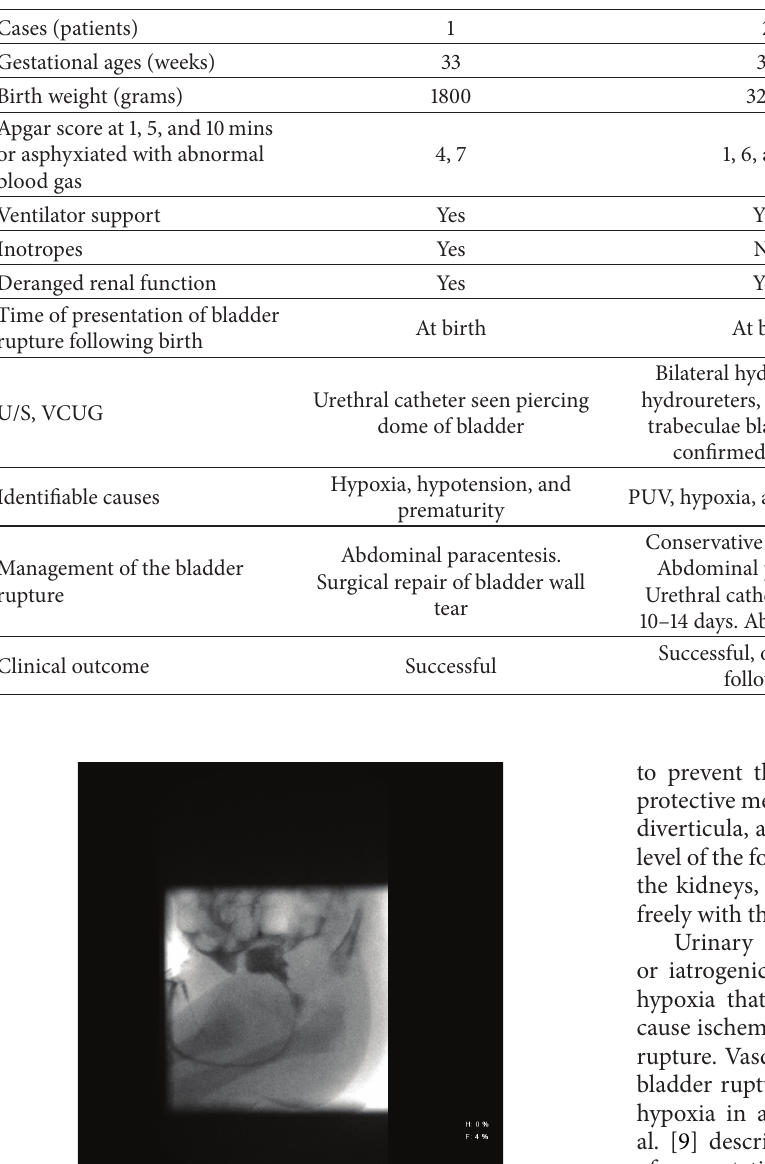
Table 1: Summary of the various cases and the management.